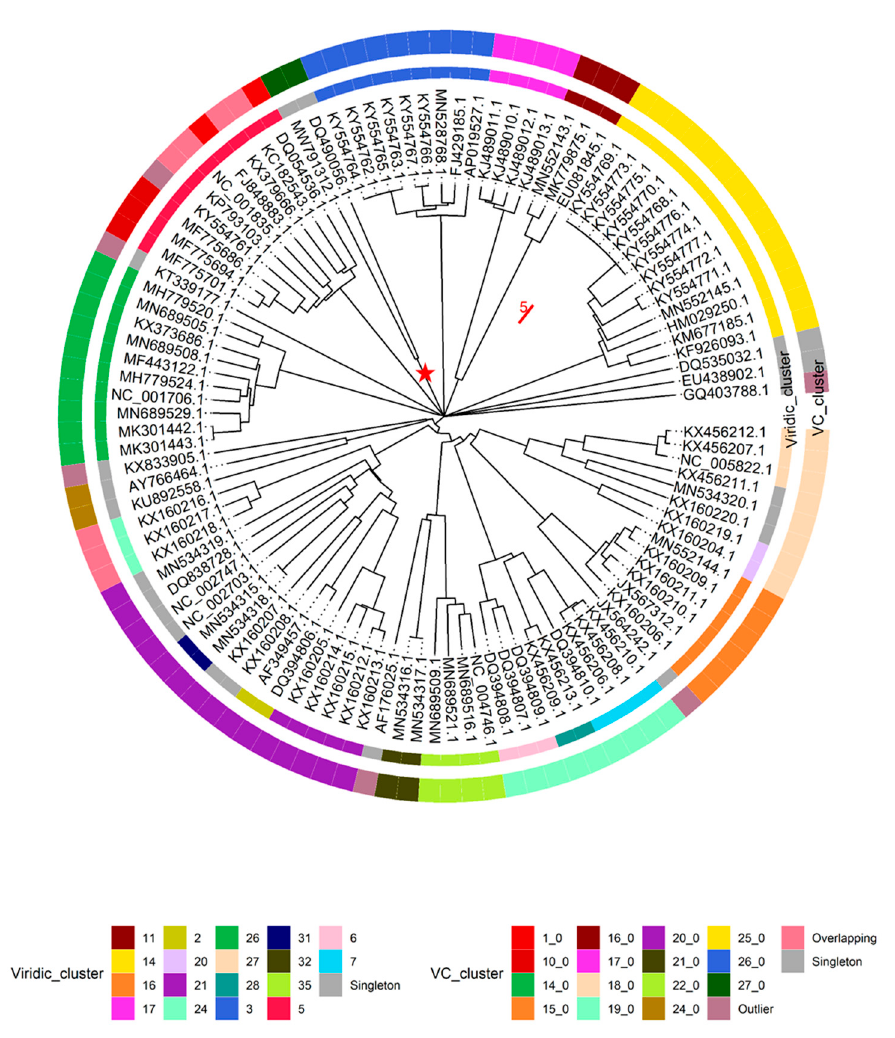
Figure 3. Genome nucleotide sequence similarity (VIRIDIC) and proteome content similarity (vConTACT2) based clustering com- parison of Lactococcus phages without genus level taxonomical information in complete genome entry associated metadata. The NJ circular tree was drawn to scale from a pairwise nucleotide sequence distance matrix generated by VIRIDIC ( n = 108); scale bar represents 5% nucleotide sequence divergence (phage species level complete genome nucleotide sequence similarity demarcation criterion). Tips are labeled according to genome accessions. The inner ring shows the results of VIRIDIC clustering at a 65% sequence similarity threshold and is colored according to the “Viridic_cluster” legend ( n = 108 analyzed and shown). The outer ring shows the results of proteome similarity-based clustering of Lactococcus phages employing vConTACT2 and is colored according to the “VC_cluster” legend ( n = 348 analyzed, n = 108 shown). Ten phages corresponding to “Viridic_cluster 5” (red inner ring part) and “Viridic_cluster 26” (green inner ring) are 9 randomly selected +1 entries that were classified as, respectively, Skunavirus or Ceduovirus in complete genome entry associated metadata. The branch leading to “MRCA” node of phages Nocturne116 and Q54 is annotated with a red star. The tree was created using “ape” [47] and annotations were visualized using “ggtree” [48] R